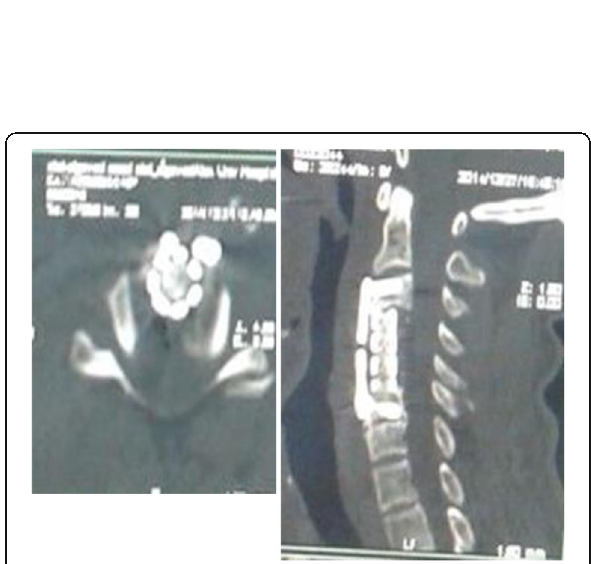
Fig. 6 CT of cervical spine showing C4 and C5 corpectomy, mesh graft, and plating of C3 and